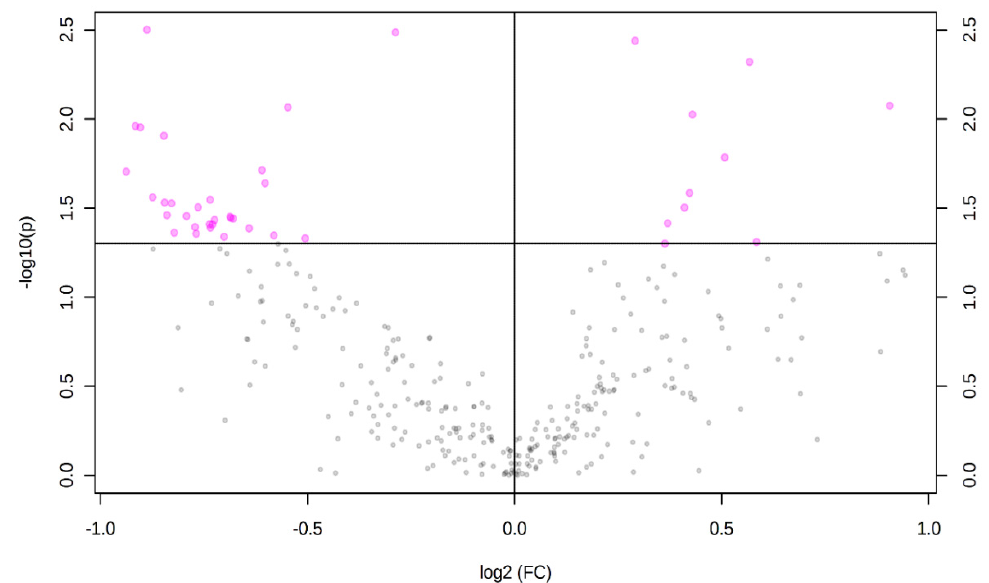
Figure 2. Volcano plot showing the differentially abundant carboxylic-acid-containing plasma metabolites (FC ≥ 1.2 or ≤ 0.83; p ≤ 0.05) between LF and HF steers. LF = beef steers with lowest average daily gain; HF = beef steers with highest average daily gain. Purple dots represent the differentially abundant metabolites.